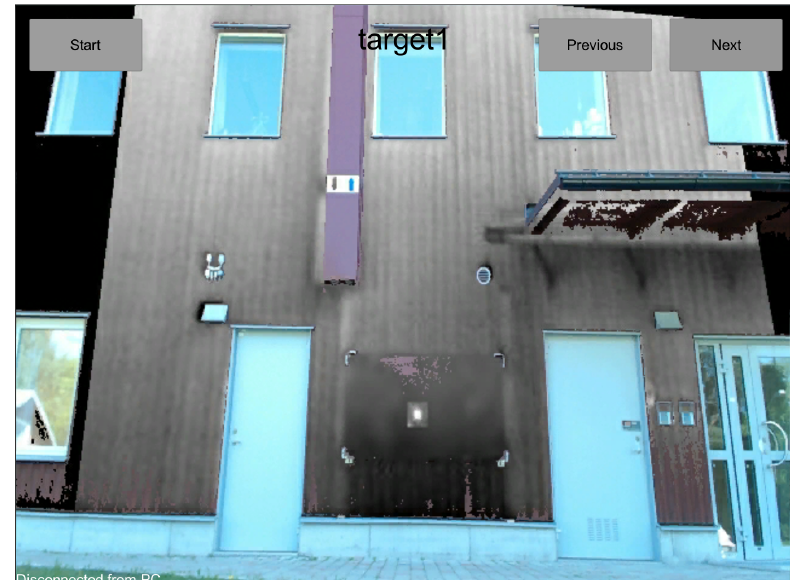
Figure 4. A screenshot of the application running on the tablet viewed by users. Notice the façade region is replaced by IR information due to chroma keying composition and the IR image of target No. 1 (the bright spot between the two doors) is correctly registered with the visible video frames.